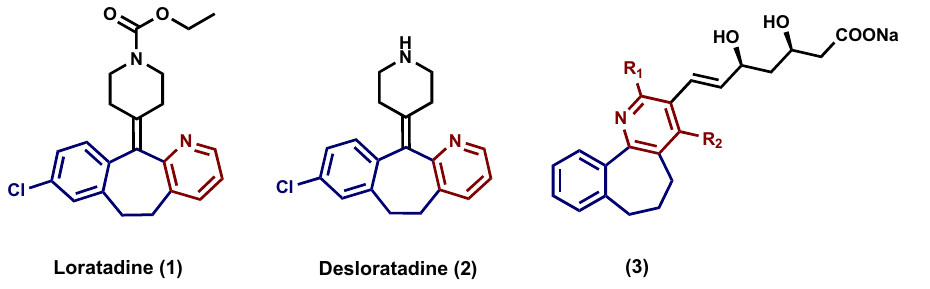
Figure 1. Some dihydro-benzocyclohepta[1,2- b ]pyridine containing